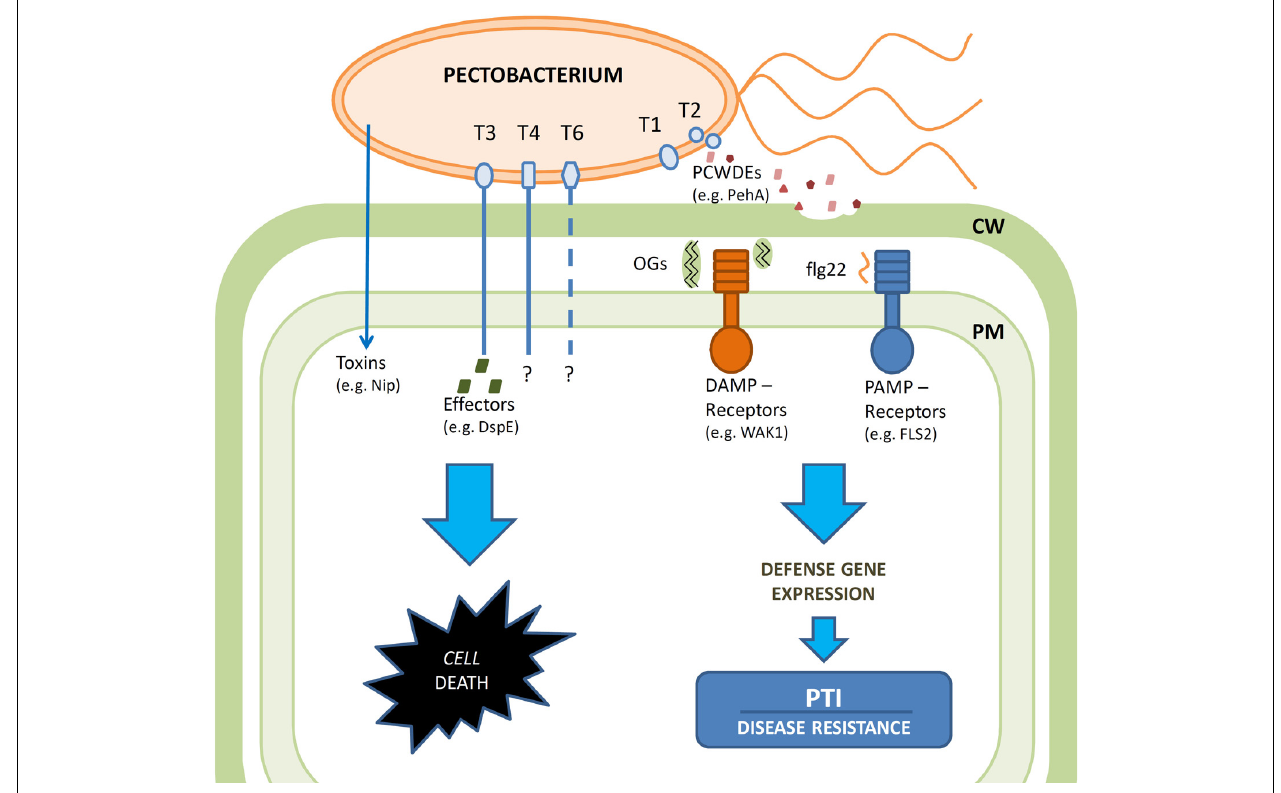
patterns (DAMPs) such as OGs released by the action of PCWDEs by respective pattern recognition receptors.These recognition events in turn trigger partly overlapping defense responses including induction of defense gene expression and synthesis of various defensive compounds such as phytoalexins, defensins and PR-proteins – resulting in PTI. Bacteria can attenuate PTI particularly in the early phase of infection by tight control of PCWDE production minimizing DAMP generation.The defenses are overwhelmed at later stages by promotion of cell death and massive PCWDE production at high bacterial cell